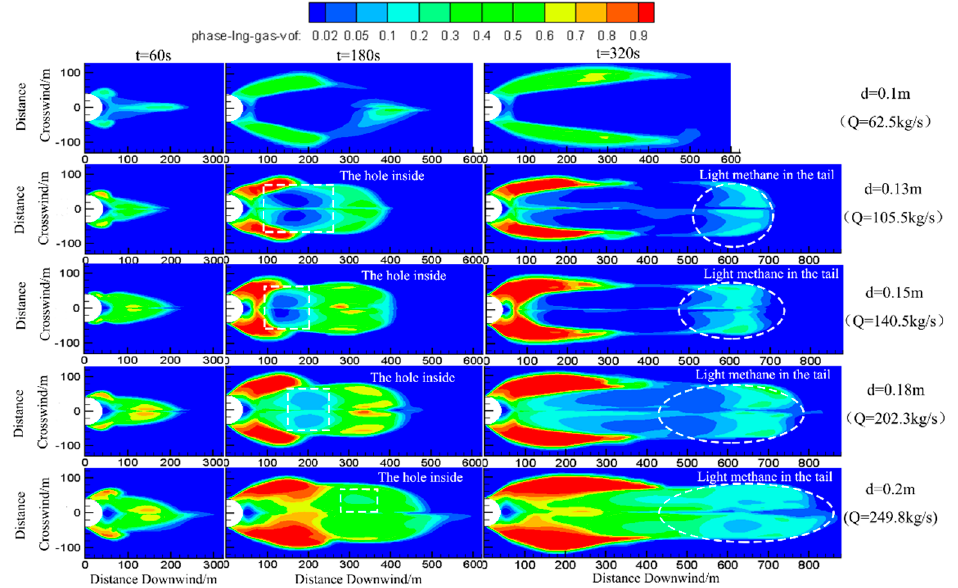
Figure 10. Variation of gas cloud concentration distribution at y = 0.5 m plane under different leakage apertures.